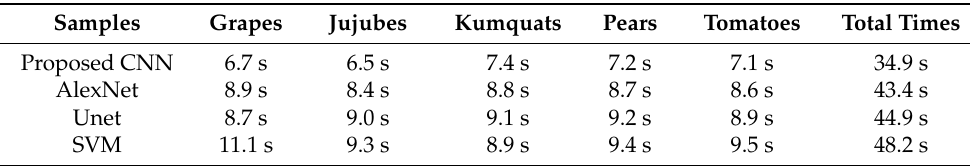
Table 4. Testing times using four different methods.